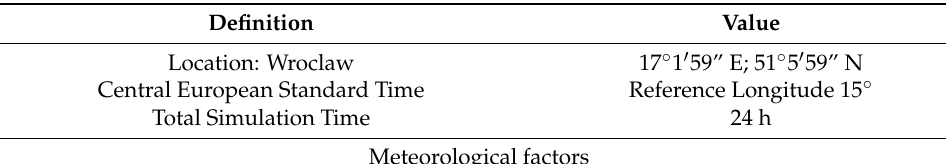
Table 4. ENVI-met configuration file